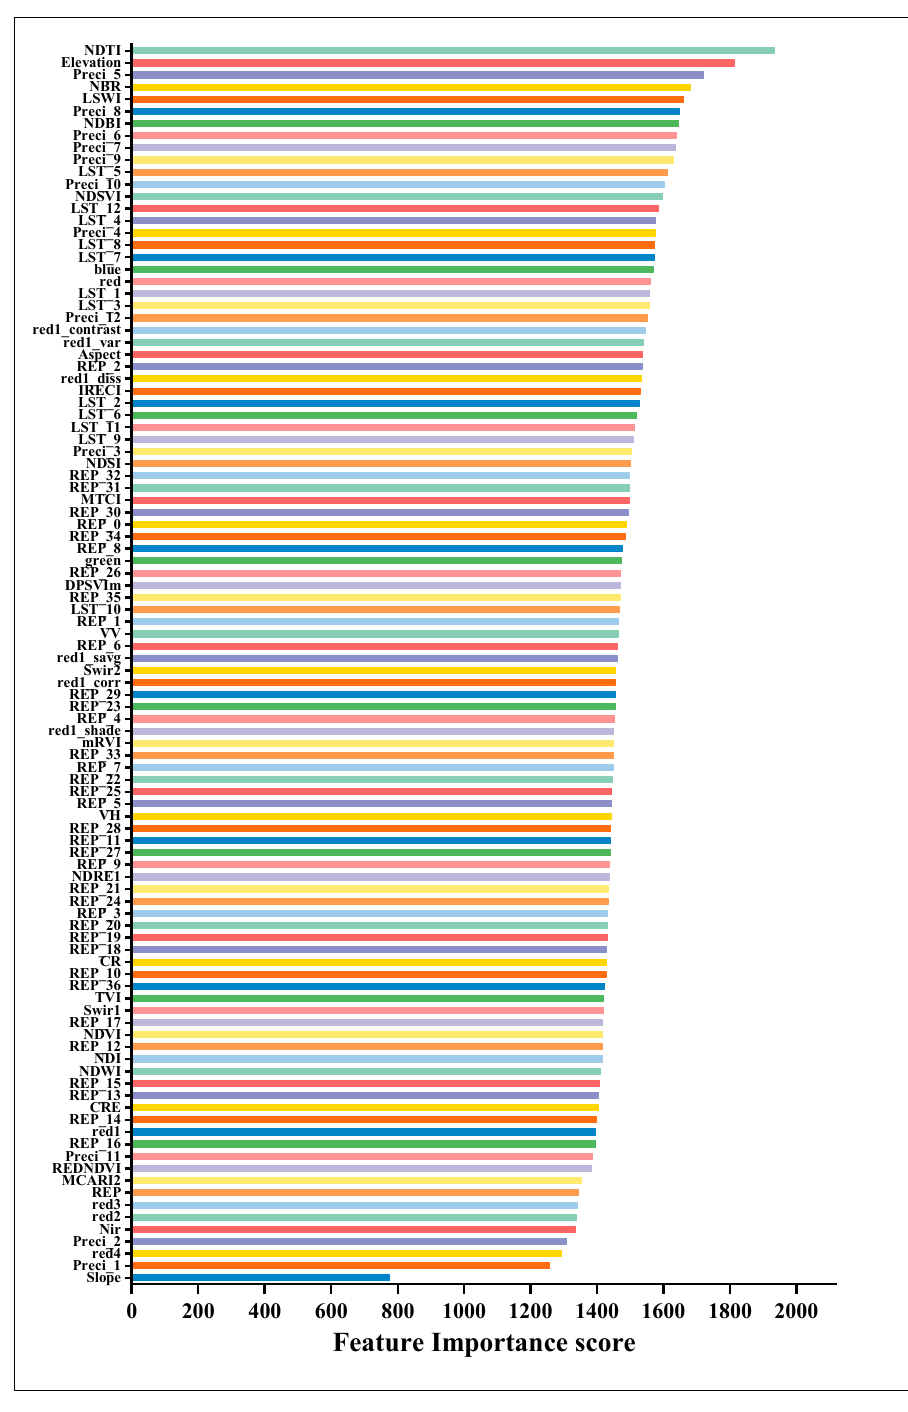
Figure 10. RF feature importance results based on case 7 for tree species classification. The feature abbreviations in the figure can be found in Section 2.2.1. With LST as a prefix representing land surface temperature and with “Preci” as a prefix representing precipitation, the number after them represents the month. The number after REP represents the time information in steps of 10 days.